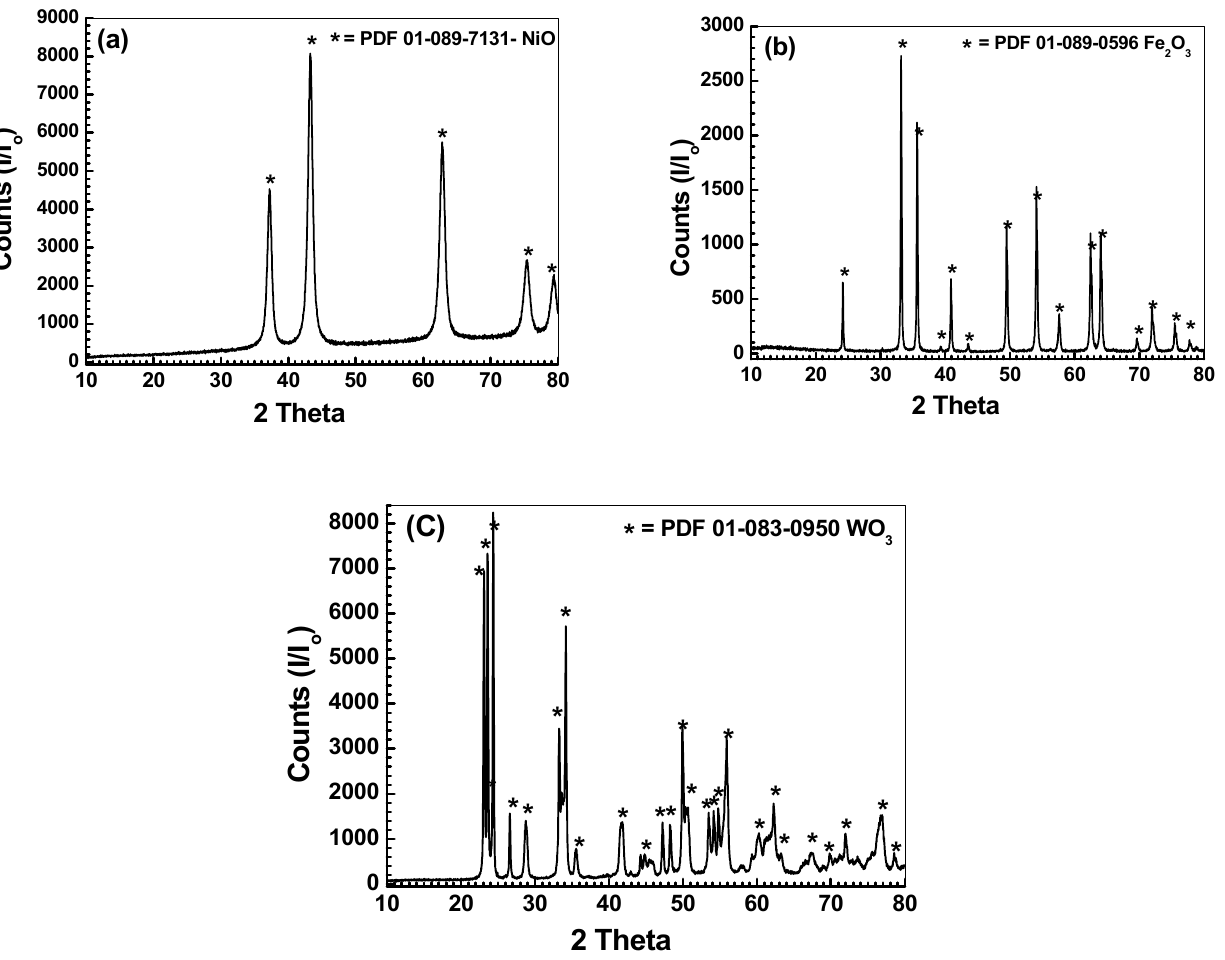
Figure 1. XRD phase analysis of nanosized metal oxides: ( a ) NiO; ( b ) Fe 2 O 3 ; ( c ) WO 3 .